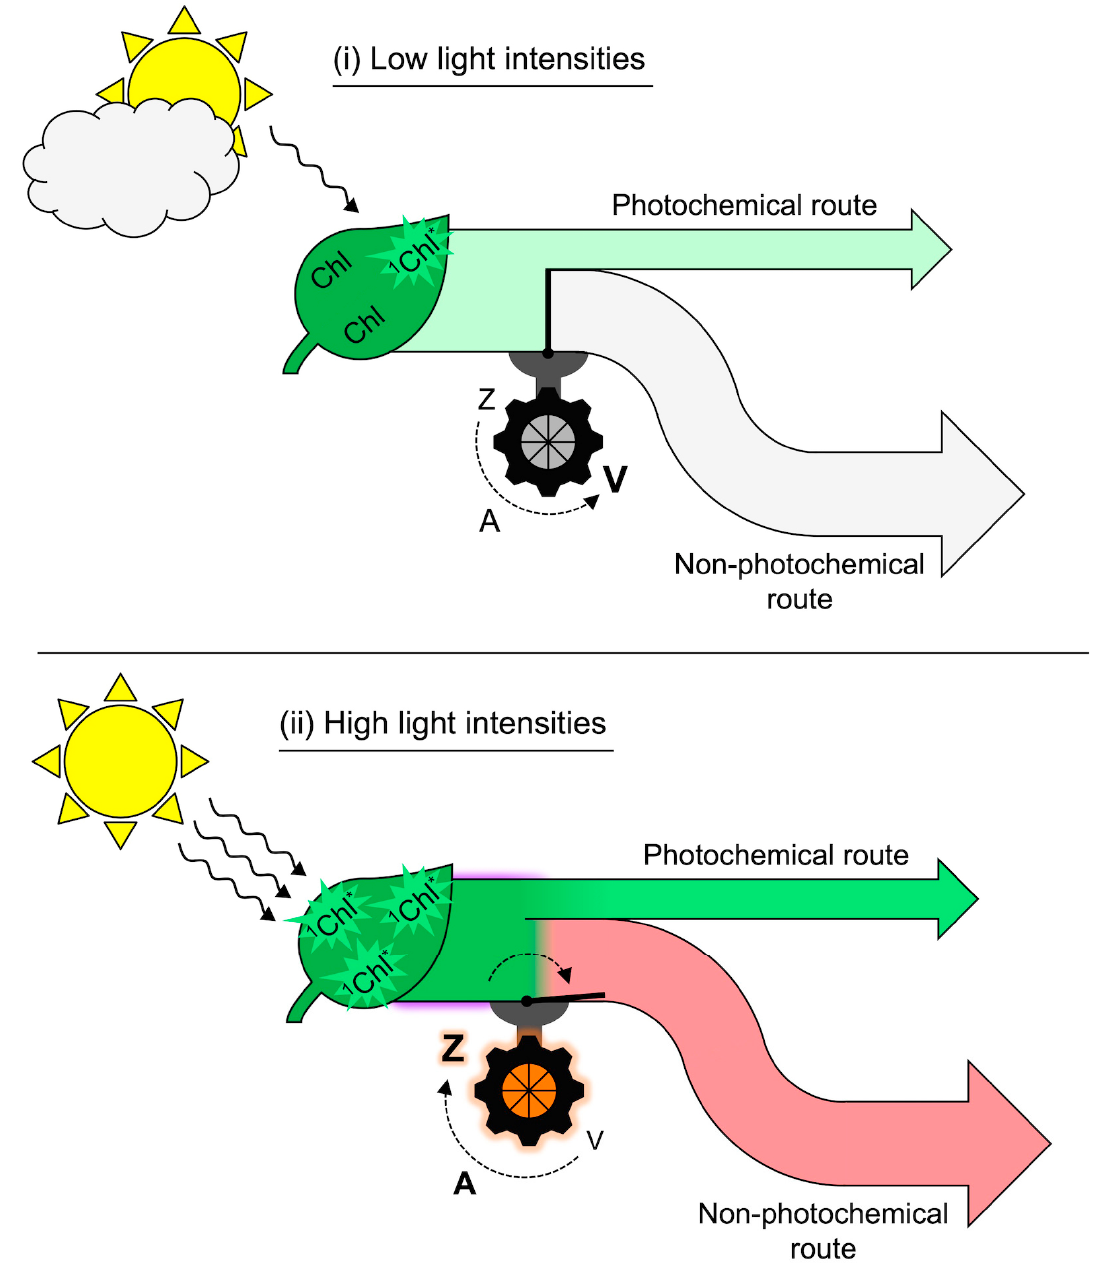
Figure 12. Schematic depiction of ( i ) absorption of low levels of light by chlorophyll (Chl) and allocation of that excitation energy to photochemistry (light green arrow) coupled with conversion of zeaxanthin (Z) to violaxanthin (V) through the intermediate antheraxanthin (A) and closure of the route to regulated non-photochemical energy dissipation versus ( ii ) absorption of high levels of light by chlorophyll and allocation of more excitation energy to photochemistry (dark green flux) coupled with conversion of violaxanthin (V) to zeaxanthin (Z) through the intermediate antheraxanthin (A) and opening of the path to regulated non-photochemical energy dissipation, resulting in a large fraction of excitation energy dissipated as thermal energy (light red arrow). 1 Chl* = singlet excited-state chlorophyll.